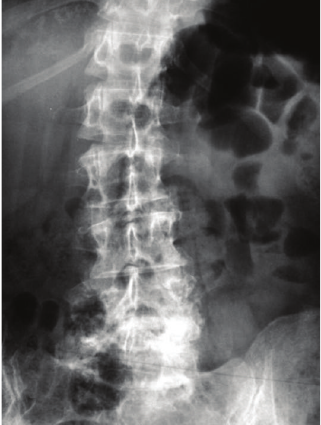
Figure 6: Anteroposterior radiograph shows leftward translation of L4 (Case 2).